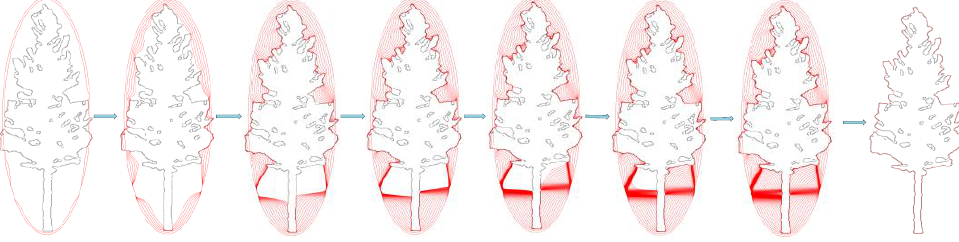
Figure 9. Changing course of snake curve on a randomly selected tree.